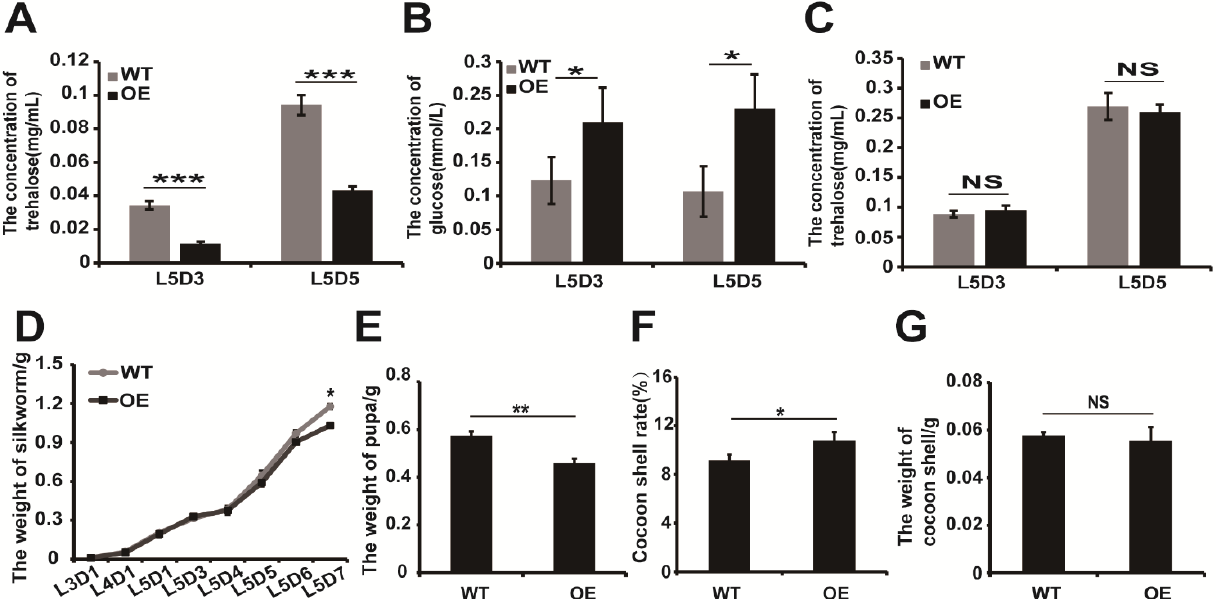
Figure 6. The effect of transgenic overexpression of silkworm estrogen-related receptor on the development of the last instar silkworm larvae. ( A ) Detection of trehalose content in the midgut of the last instar silkworm; ( B , C ) Detection of glucose/trehalose content in the hemolymph of the last instar silkworm; ( D ). Body weight during the feeding stage of the silkworm larvae. ( E – G ) Pupa weight/Cocoon shell ratios/Cocoon shell weight of silkworms. The data represent the mean ± standard deviations ( n = 30). The significant difference between data sets was calculated using two-tailed Student’s t -tests; * p < 0.05; ** p < 0.01. *** p < 0.001.